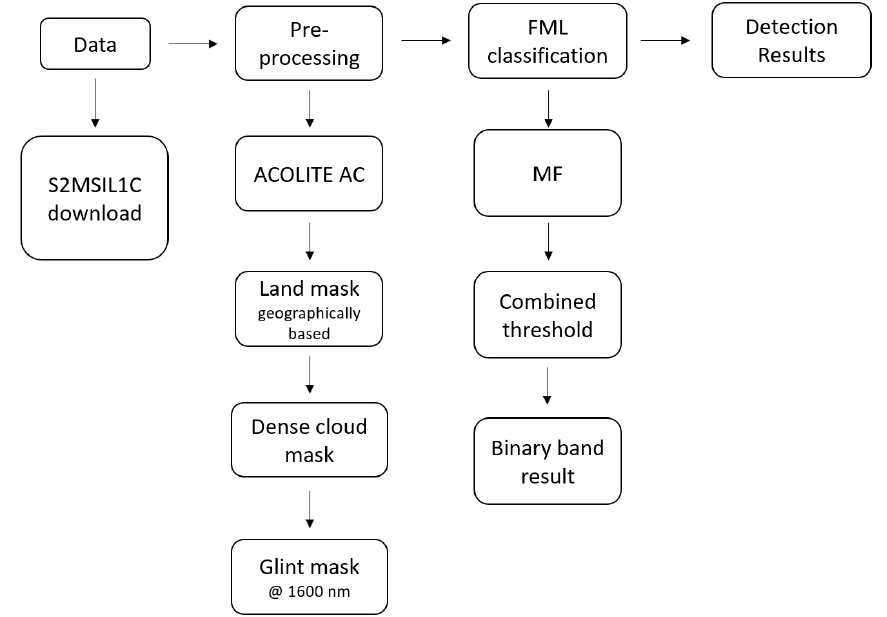
Figure 3. Processing workflow for FML detection through partial unmixing.